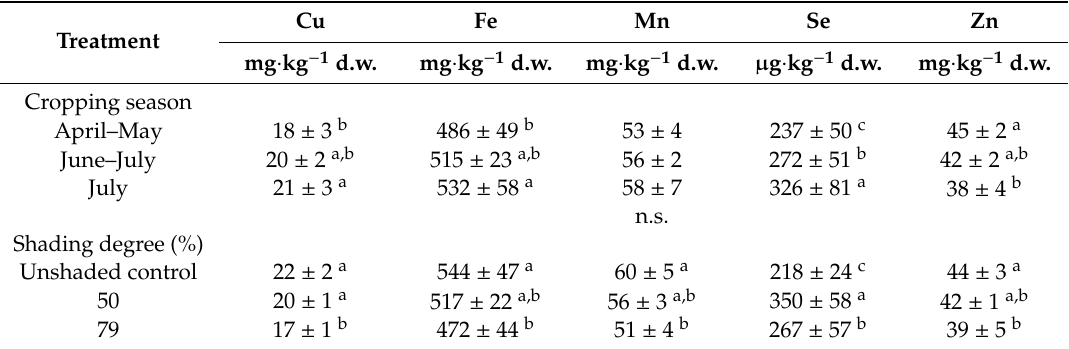
Table 4. Microelement content in perennial wall rocket leaves as a ff ected by cropping season and shading degree.